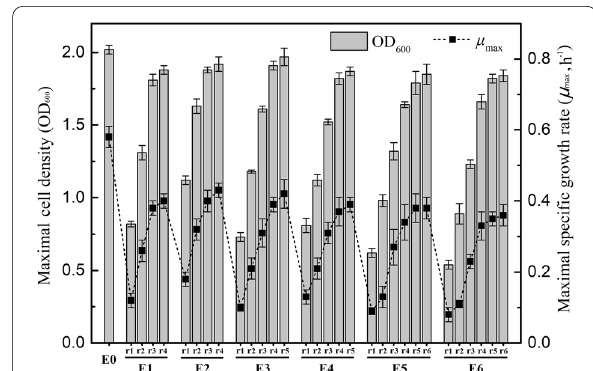
Fig. 1 Comparison of the maximal cell density and specific growth rate of strains evolved under the stress of different concentrations of inhibitors. E0 represents the starting strain E. coli LGE2 growing in LB media without inhibitors. r1–r4 of E1 represent the strains that were evolved by four-round transfers in the same concentration of inhibitor cocktail composed of 0.7 g/L acetic acid, 0.8 g/L furfural, and 0.6 g/L phenol. For E2, the inhibitor concentration was increased by 0.14 g/L acetic acid, 0.16 furfural g/L, and 0.12 g/L phenol compared to E1, and this is also the increment of E3 vs E2, E4 vs E3, E5 vs E4, and E6 vs E5. r6 represents the strains that were successively transferred by six rounds. Each strain used in the new transfer was the strain obtained by the last-round evolution. These strains were all cultured microaerobically within a maximum of 96 h at 37 °C until the cells stopped